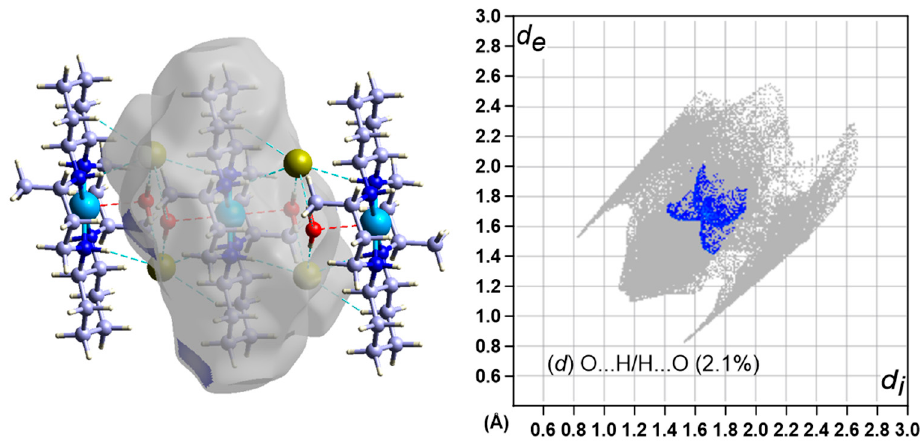
Figure 9. Hirshfeld surface mapped with ( left ) d norm , and 2D fingerprint plot ( right ) for H···O/O···H